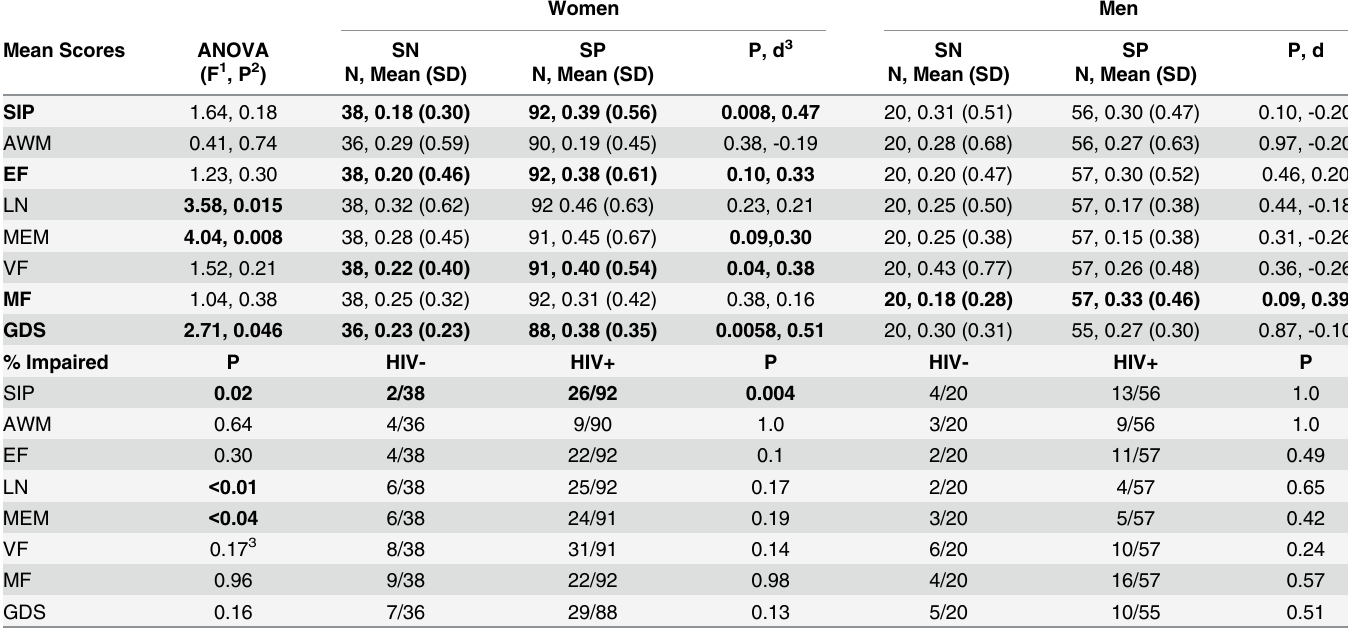
Table 4. Comparison of ability domain scores and frequency of impairment for women versus